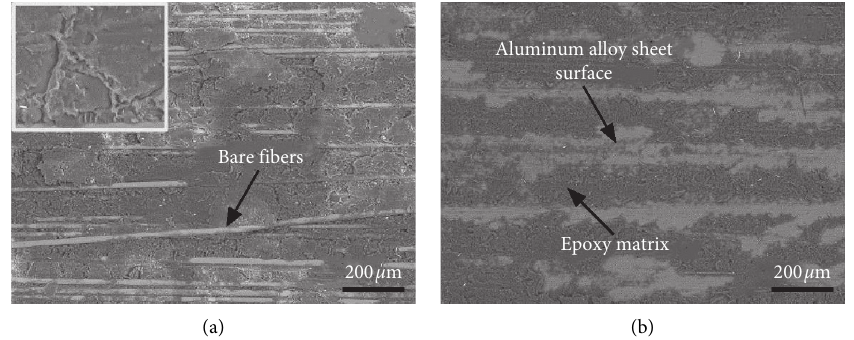
Figure 16: Micromorphology of interlaminar shear debonding surface, observed by SEM (FEI Quanta 200) [51]. (a) Composite material layer shear surface; (b) aluminum alloy layer shear surface.